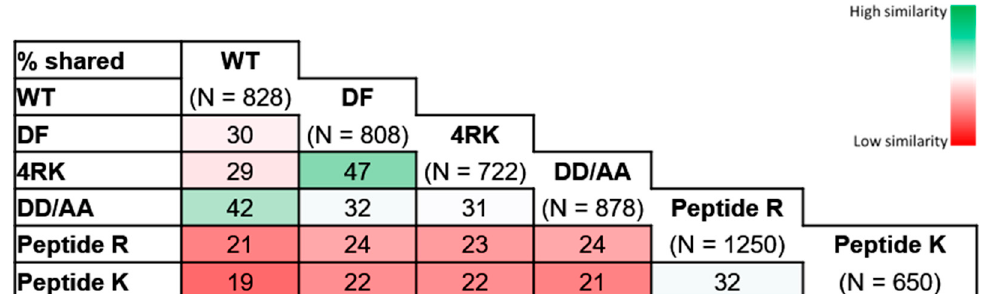
Figure 3. Similarity index for protein interactors. Heat map of the Jaccard similarity indices for the indicated pairwise comparisons. Number of genes in the interactome list indicated in the horizontal row in common with the interactome shown at the top (WT: wt-CFTR interactome, DF: F508del-CFTR interactome, 4RK: F508del-4RK-CFTR interactome, DD/AA: DD/AA-CFTR interactome for full-length CFTR and Peptide R and K interactomes). % shared (similarity) was obtained using the Jaccard similarity index.